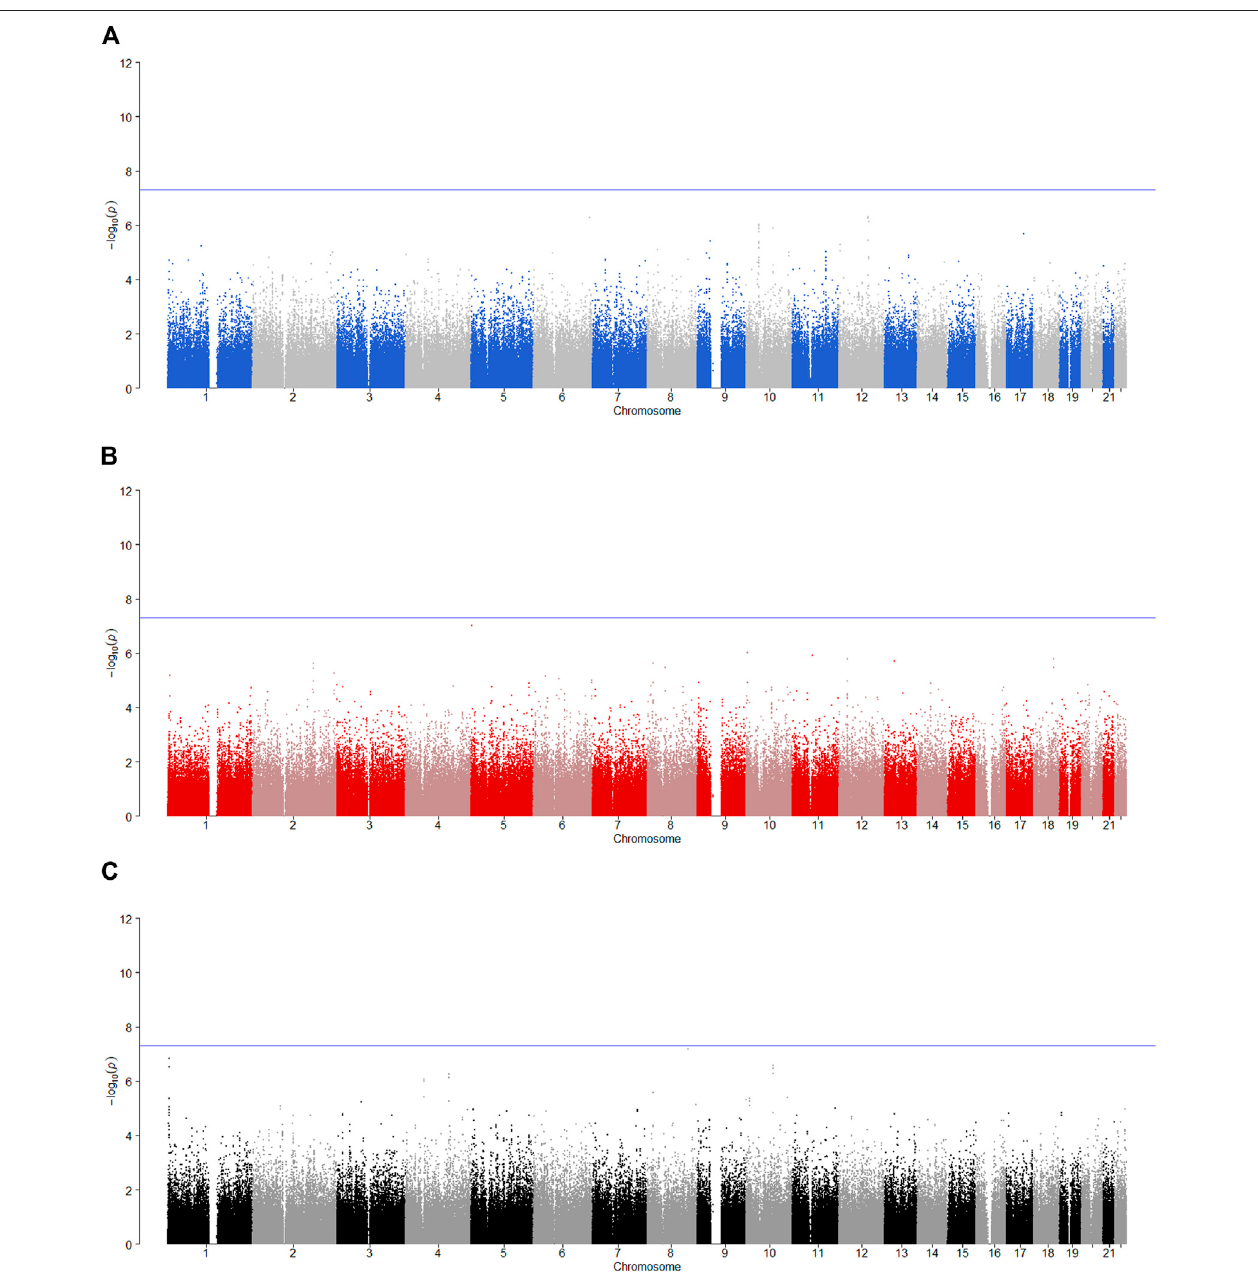
FIGURE 2 | Manhattan plot for POE and genotypic effect tests of nicotine ( N = 2,185). The blue line represents the signi fi cance level α (cid:1) 5 × 10 − 8 , which is the signi fi cance level of GWAS. (A) Paternally derived effect, (B) maternally derived effect and (C) genotypic effect.